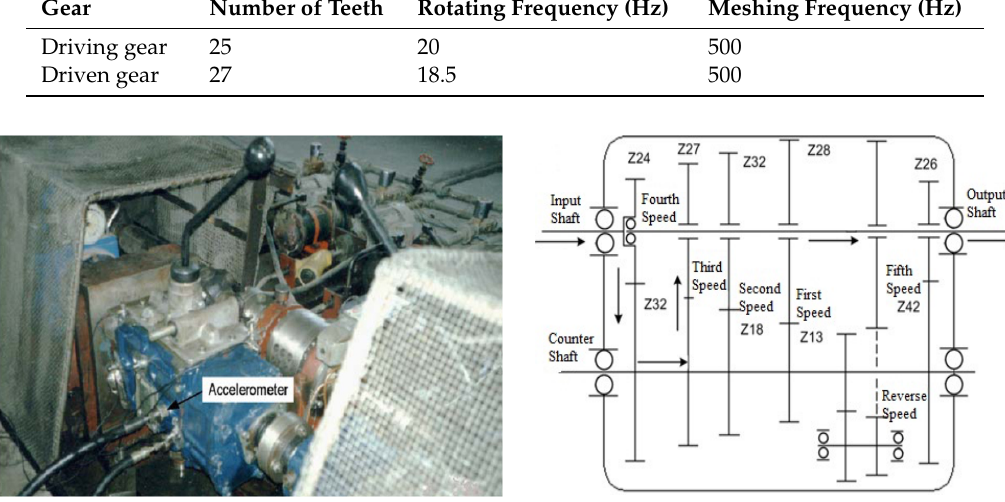
Figure 9. Collection platform of the gearbox vibration signal. Table 5. Gearbox health status and its running period.